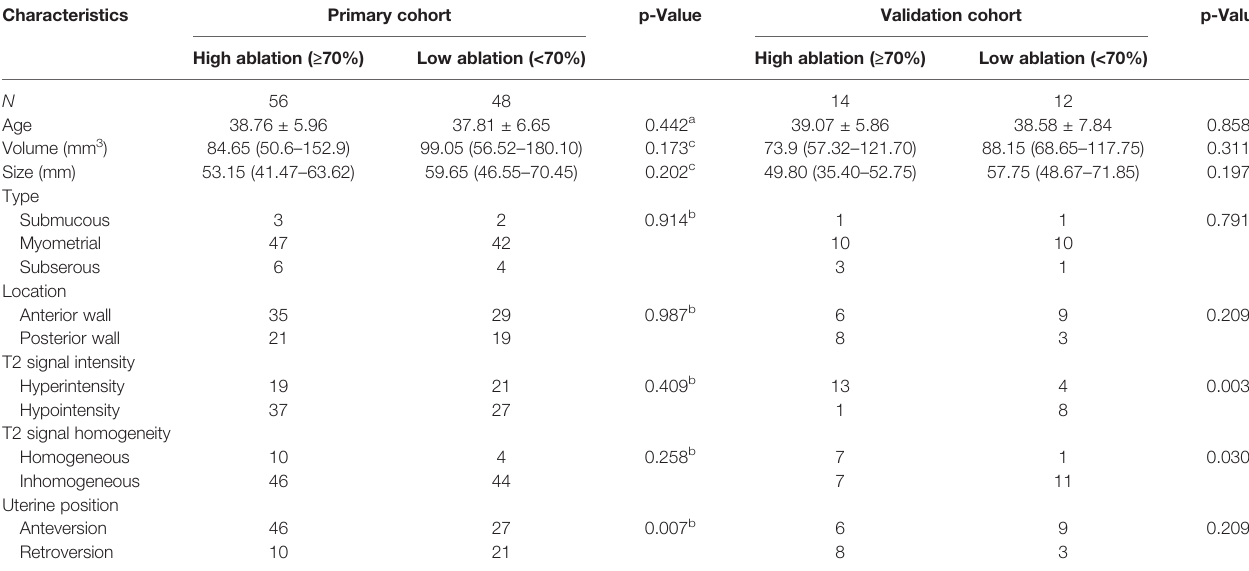
TABLE 3 | Demographic information and radiological image characteristics between the high and low ablation groups.